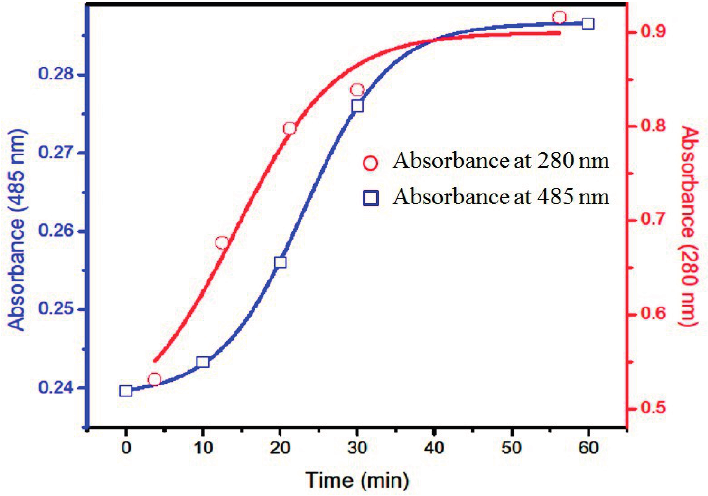
Figure 3. Absorbance spectrum of hair dye with time in presence of Fe(III) at 280 nm and 485